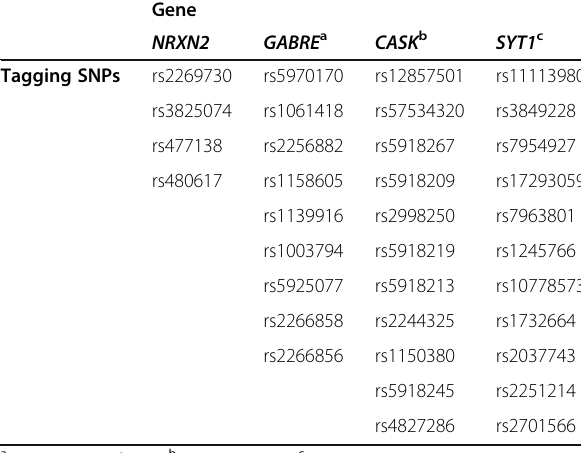
Table 1 Tagging SNPs selected for each gene Gene NRXN2 GABRE a Tagging